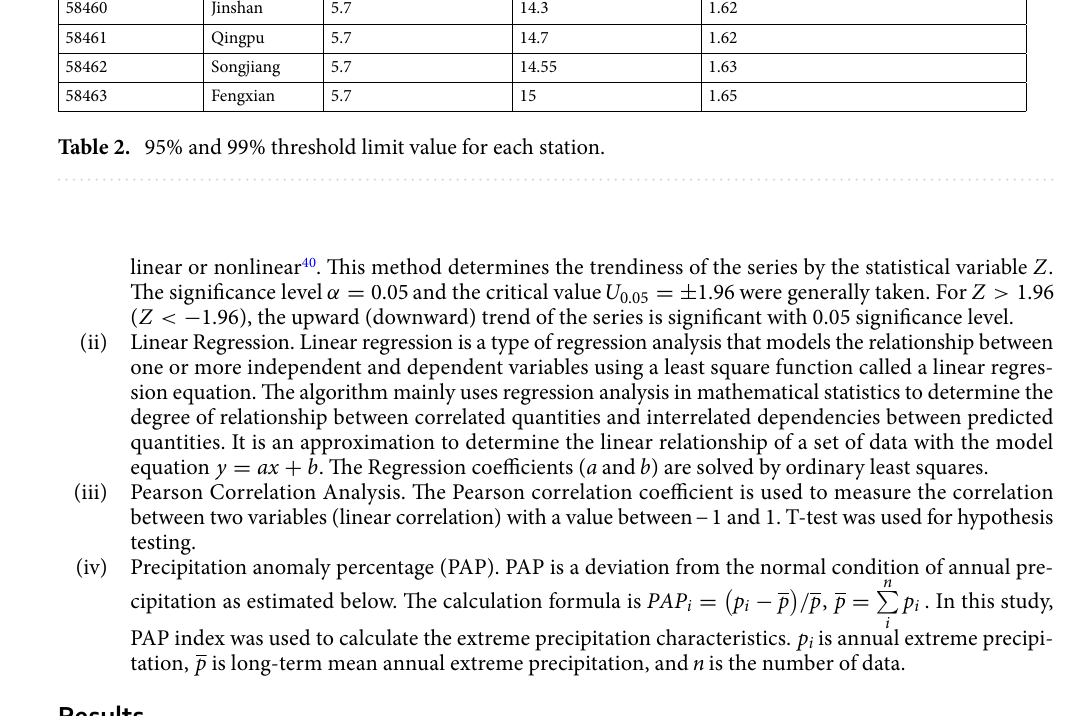
Table 2. 95% and 99% threshold limit value for each station.